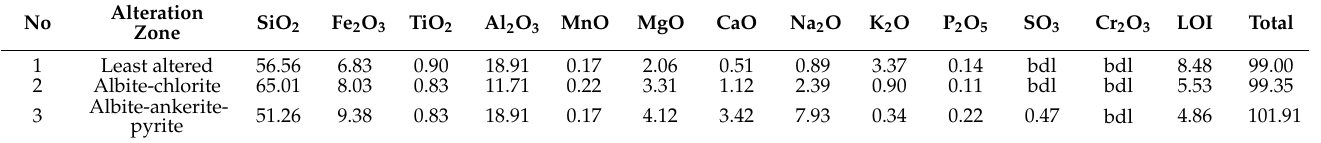
Table 2. Geochemical data of major oxides from different alteration zones measured by XRF.